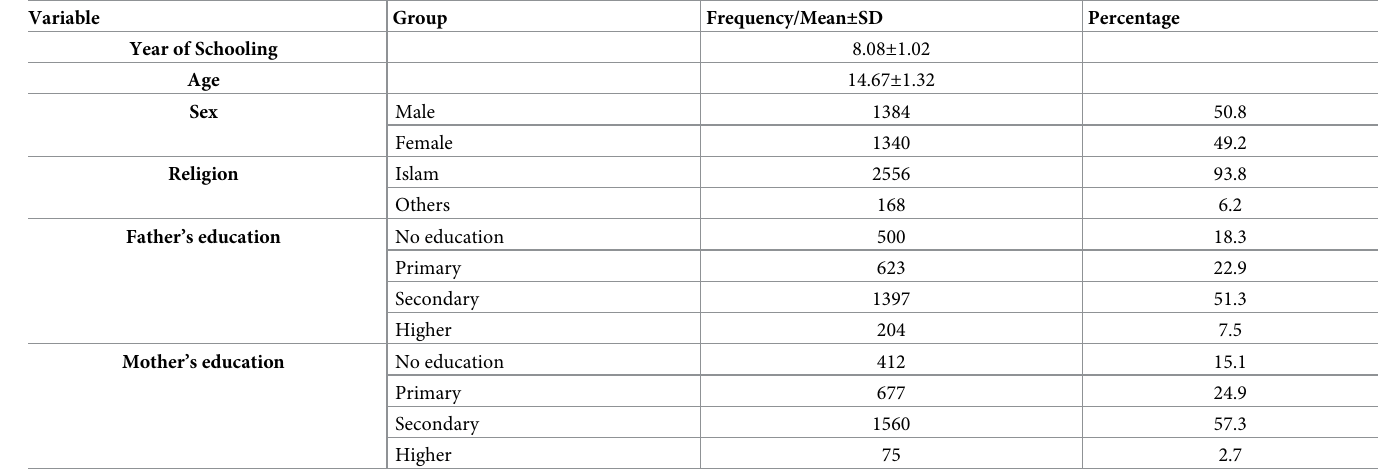
Table 1. Descriptive statistics of socio-demographic characteristics.